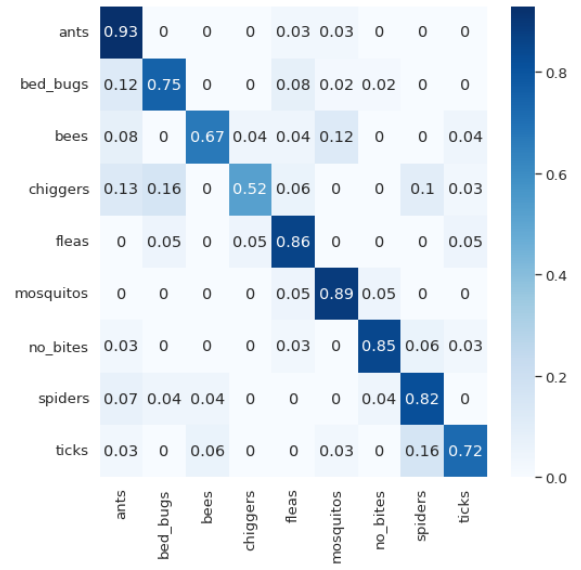
Figure 13. Normalized confusion matrix for